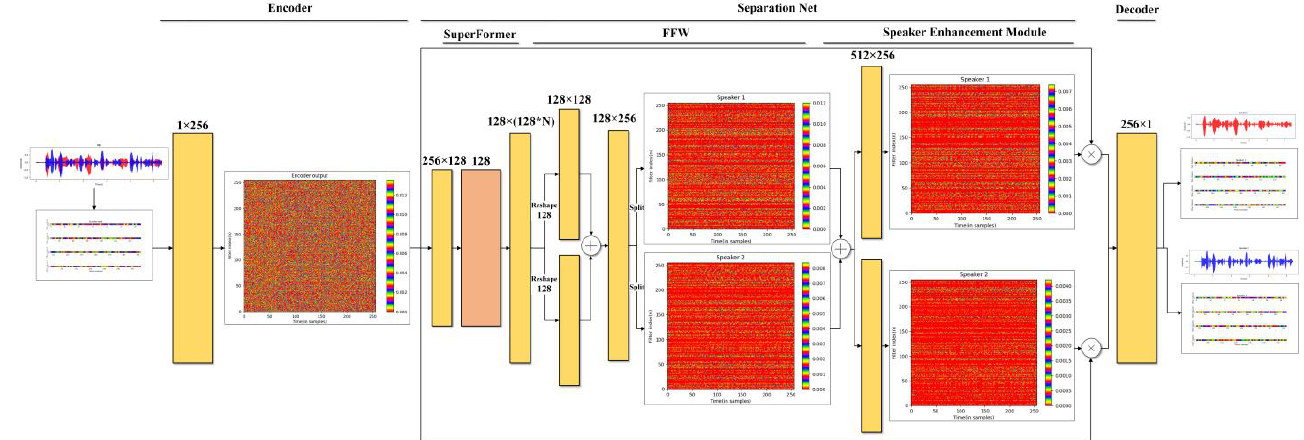
Figure 6. Visualization of speech separation process. Taking the mixing of two speakers’ speech as an example, the speaker’s speech is displayed in red and blue respectively. The number in the figure represents the change of channel dimension, in which the encoder adopts 1 × 256 convolution cod- ing. Through the autocorrelation modeling of SuperFormer, the separated speech feature map is obtained. It can be clearly seen that the speaker enhancement module improves the separation ef- fect. Finally, the decoder applies 256 × 1 transpose convolution to decode and obtain the separated speech waveform.